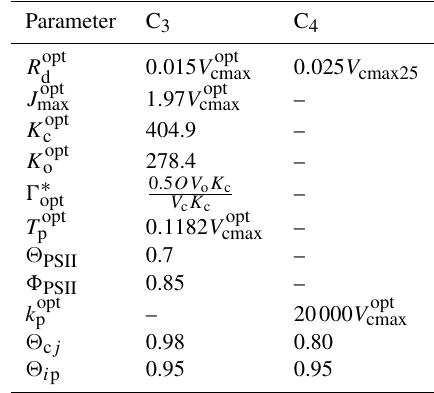
Table A1. Functional forms of photosynthesis equation